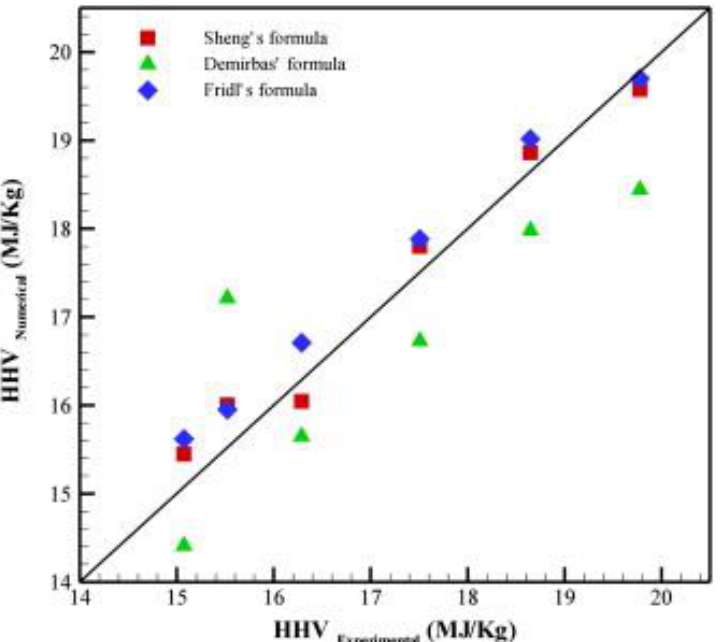
Figure 1. Differences between experimental and model HHV values. Reprinted/adapted with permission from Vaezi et al. [9].